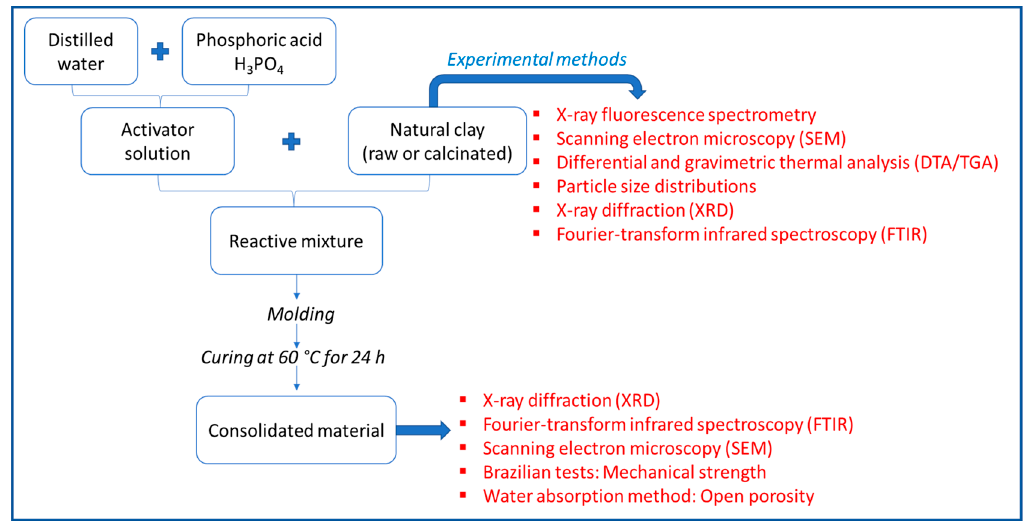
Figure 2. The flow sheet of experimental protocol and methods adopted .